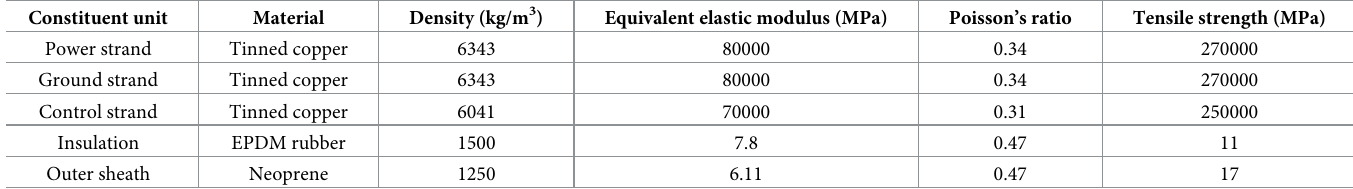
Table 1. Material parameters of each component unit of the shearer cable.